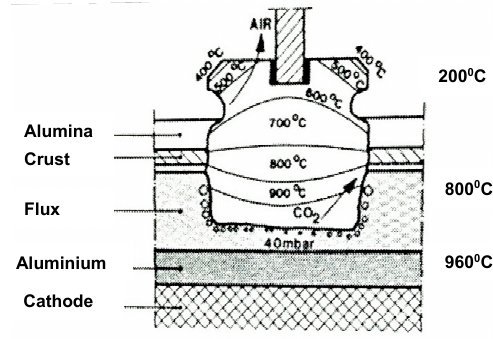
Figure 1. Reactions in the pot.